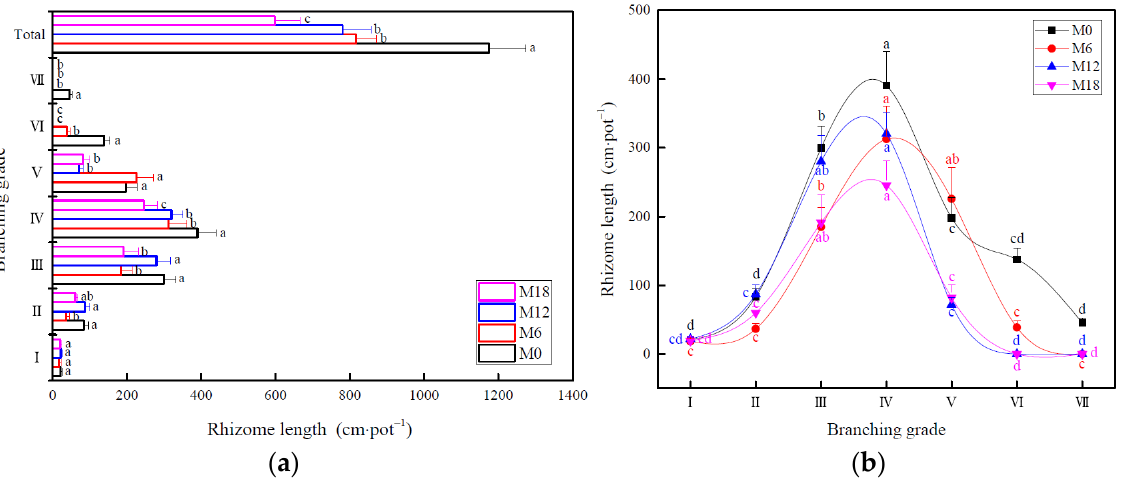
Figure 3. Rhizome length. ( a ) Quantitative characteristics of rhizome length; ( b ) variation trend of rhizome length. Different letters indicate significant differences ( p < 0.05).